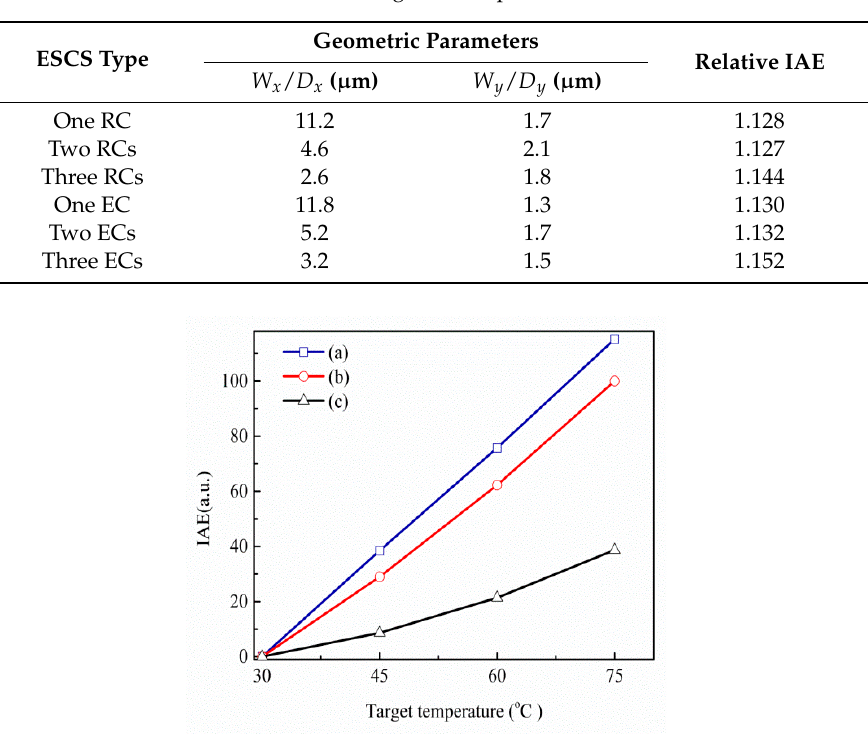
Figure 6. Variances of the IAEs with the target temperature for the SHA thermopiles of ( a ) the best case in this study and ( b ) the best case in [16], and ( c ) the thermopile without SHA.